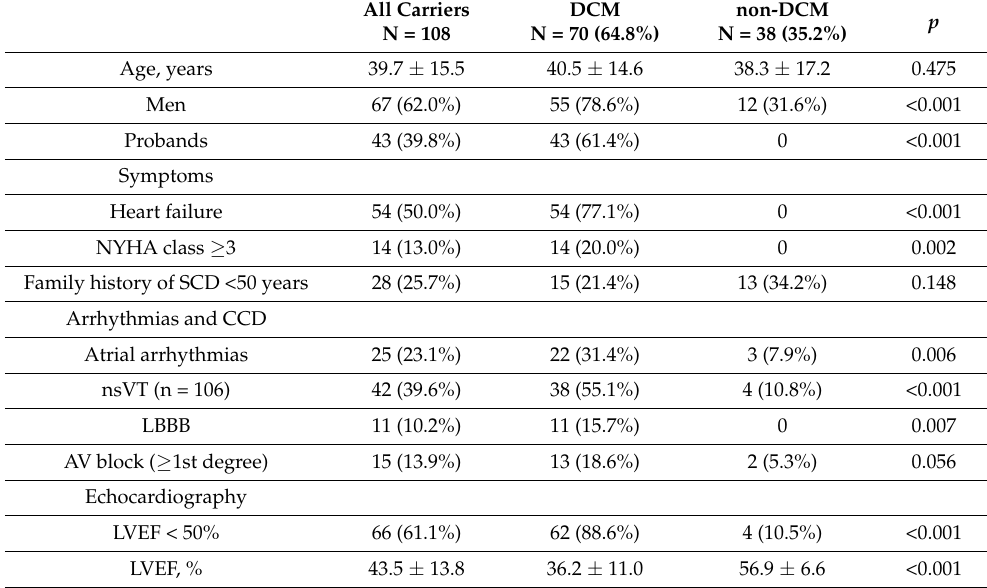
Table 1. Baseline clinical characteristics of TTN truncating variant